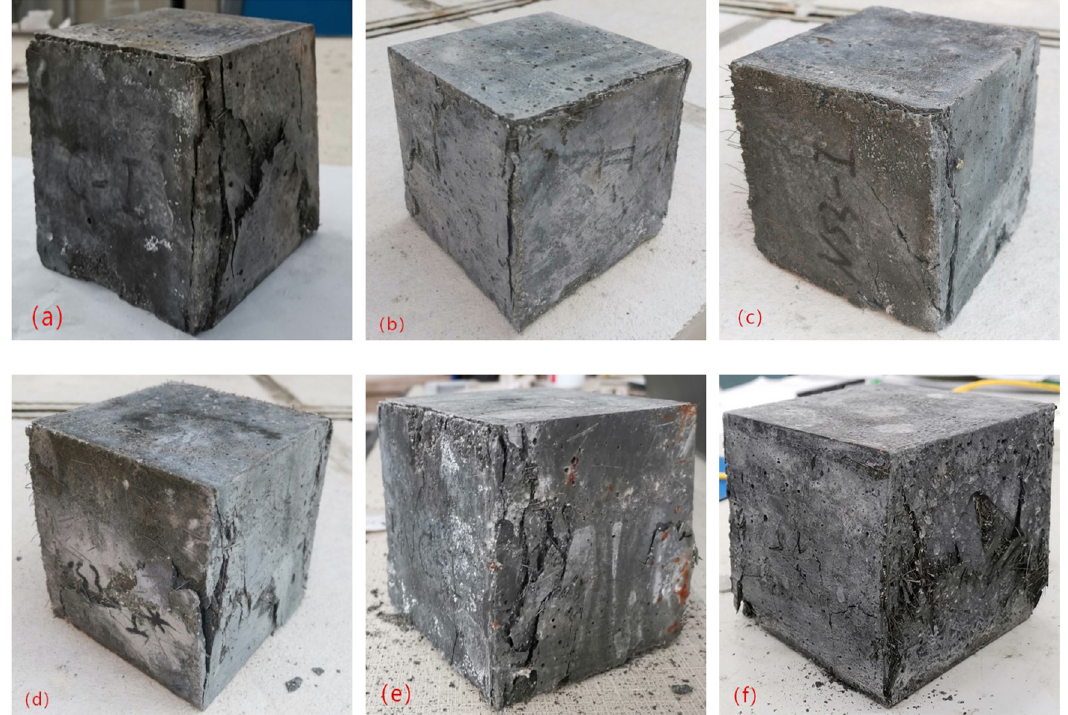
Figure 11: Failure mode of UHPC specimens: ( a ) Ref - I, ( b ) Ref - II, ( c ) NS3 - I - a, ( d ) NS3 - I - b, ( e ) NC3 - I - b, and ( f ) CNF0.15 - I -